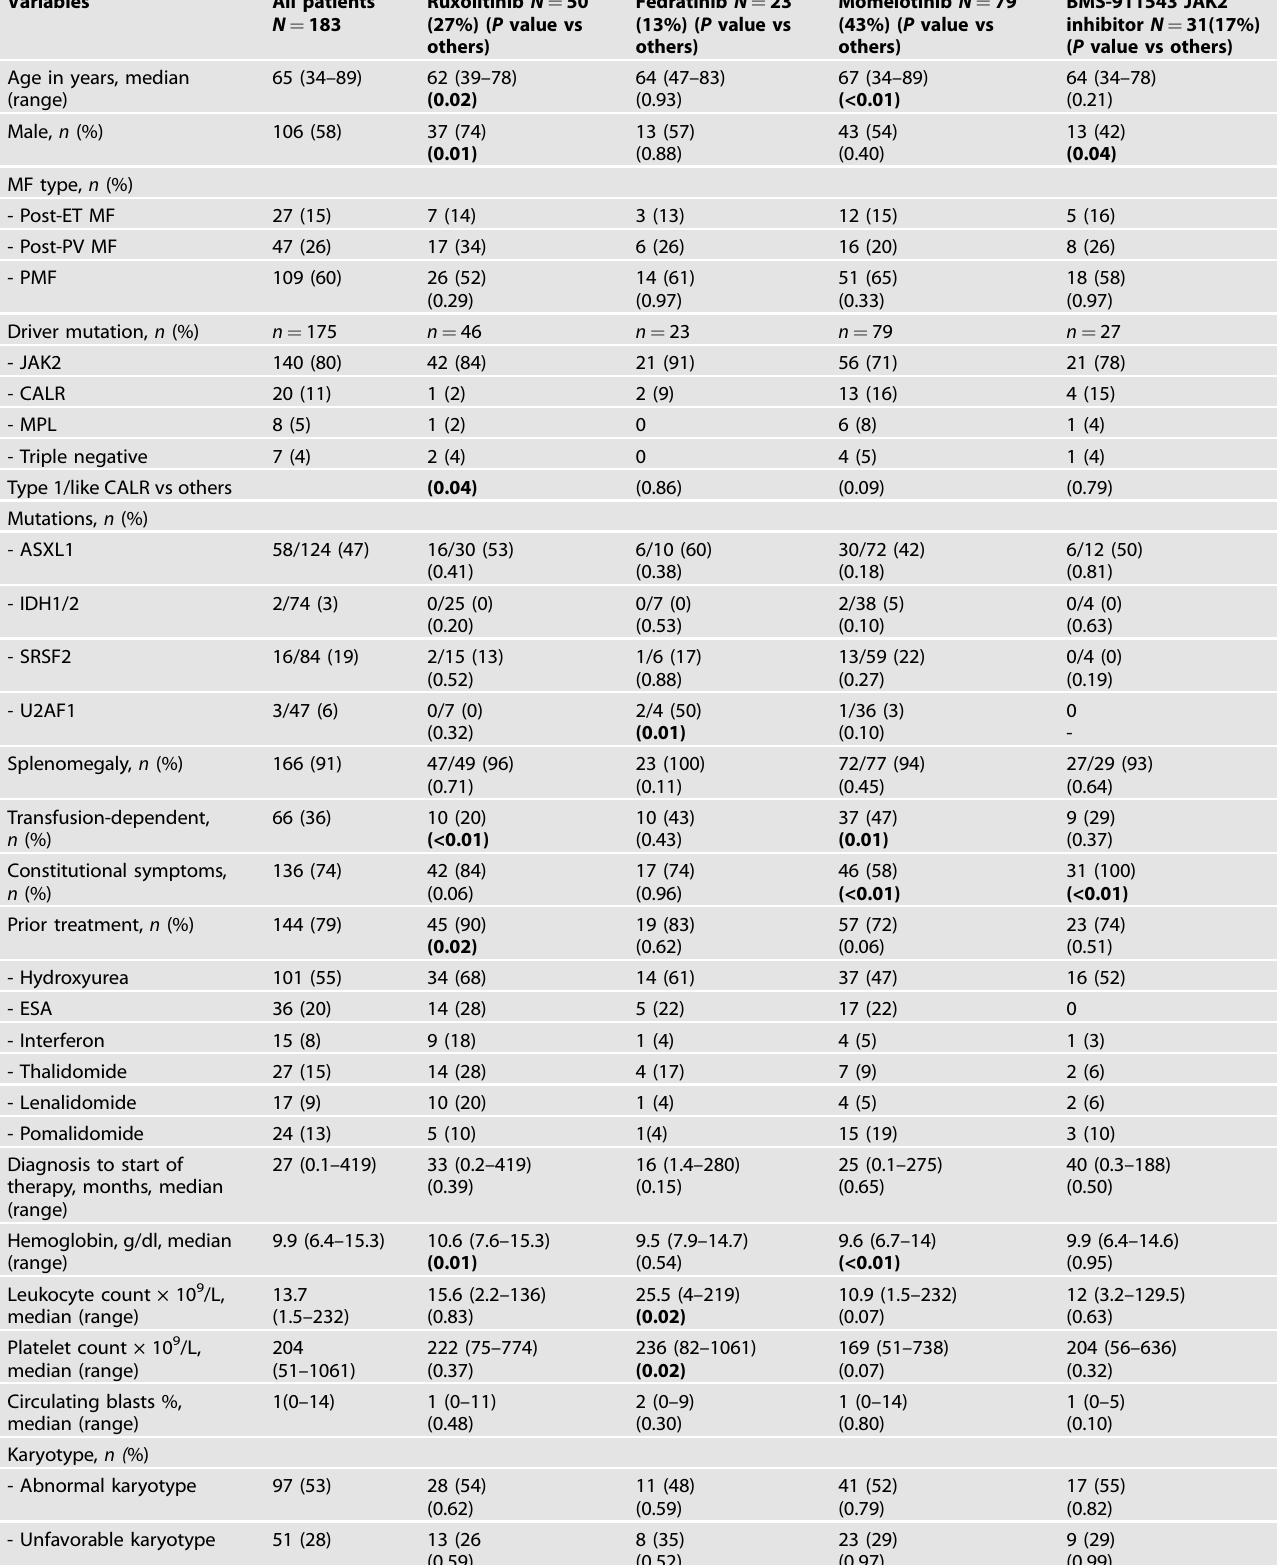
Table 1. Comparison of clinical characteristics at time of treatment initiation and outcomes for 183 JAK2 inhibitor-naive patients with myelo fi brosis receiving JAK2 inhibitors in the context of clinical